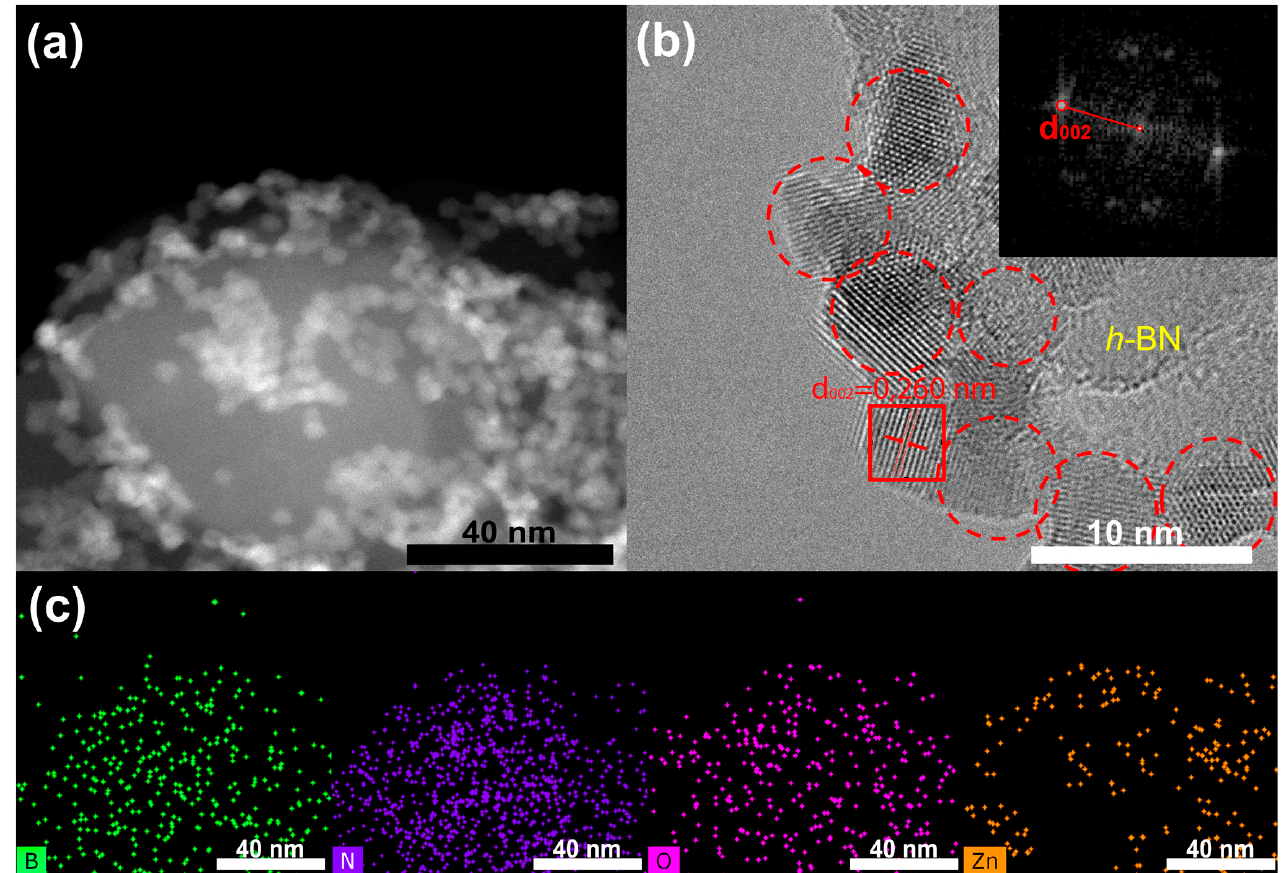
Figure 3. HADF-STEM image ( a ) with corresponding spatially resolved B, N, O and Zn EDXS elemental maps ( c ) and HRTEM image ( b ) of ZnO/h-BNnm sample. Insets in ( b ) show FFT pattern obtained from the framed area.